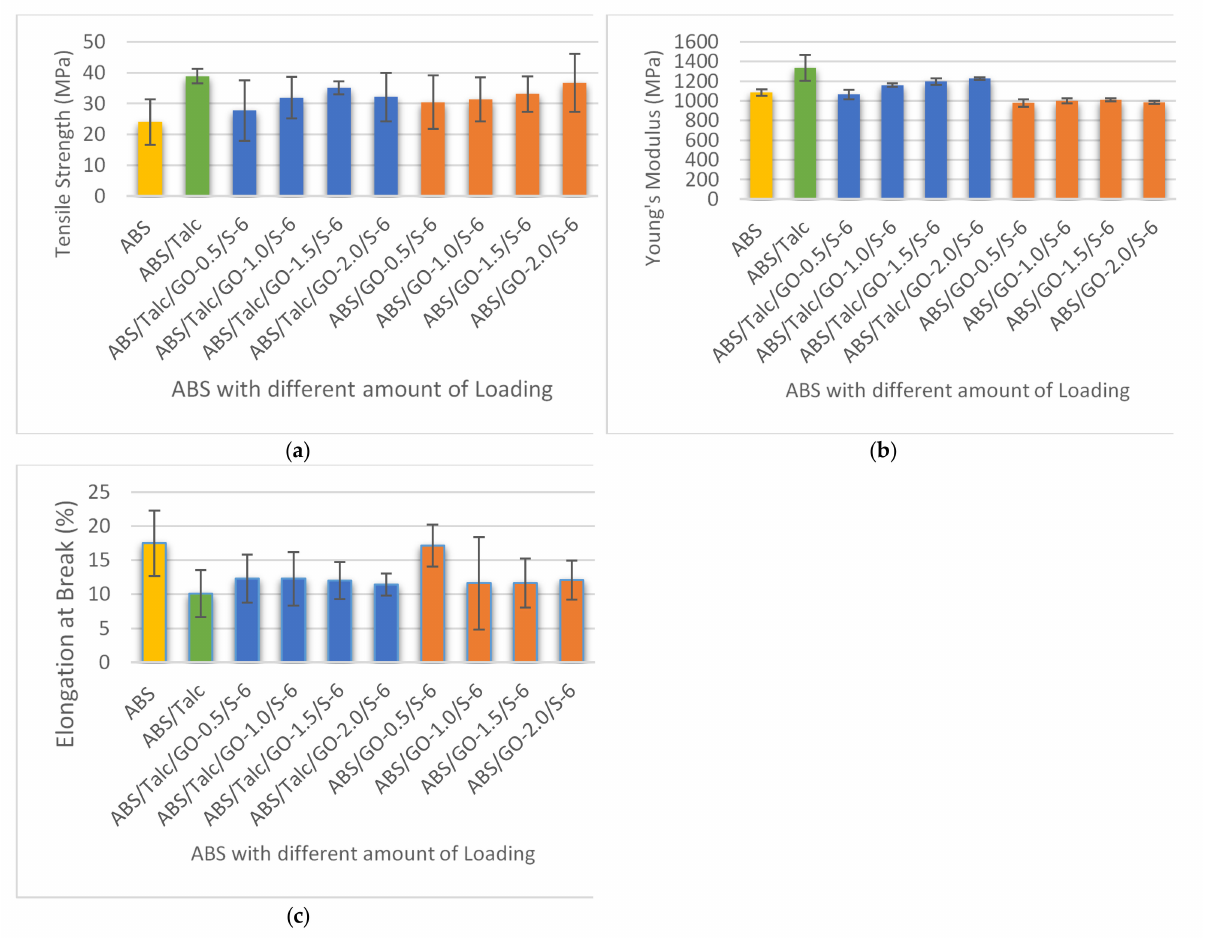
Figure 4. ( a ) Tensile strength, ( b ) Young’s modulus, and ( c ) elongation at break of ABS and ABS/talc, with different loading of